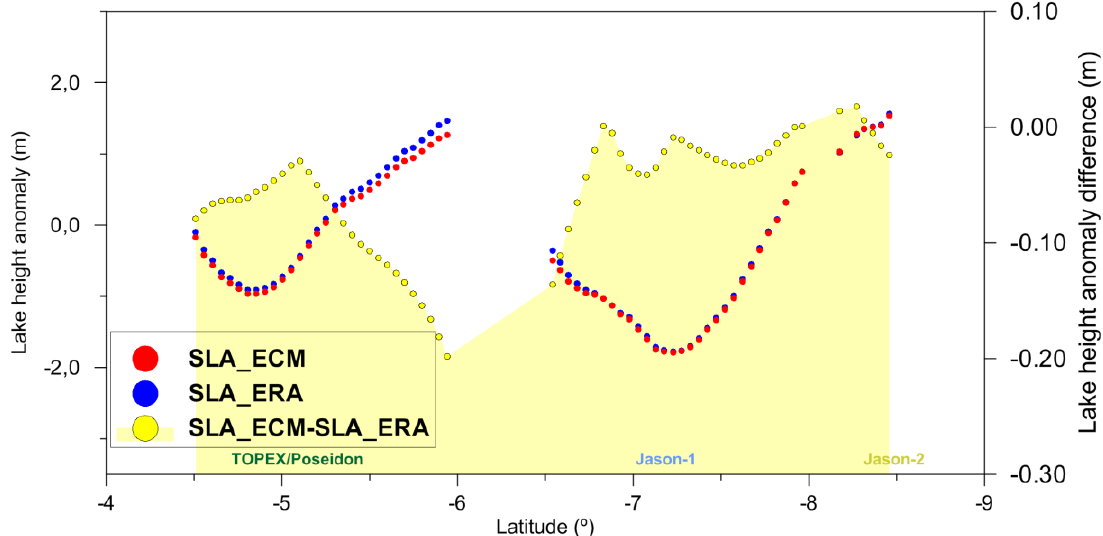
Figure 17. Mean water level anomalies (m) along T/P Pass 222 over Lake Tanganyika, derived using tropospheric (dry and wet) corrections from two models, for the period of J1 Cycles 1–149. Water level heights are with respect to the EGM2008 geoid. A mean lake height of 769 m has been removed. Results for NCEP are not shown, since they are very similar to those from ERA Interim.